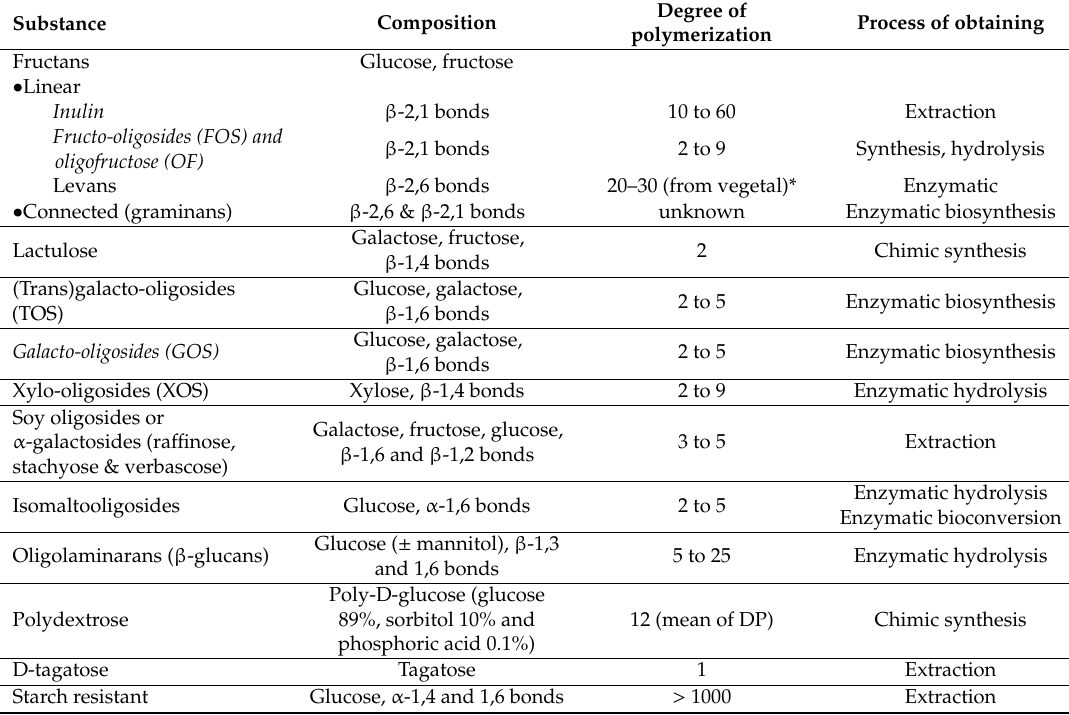
Table 1. List of proven and assumed